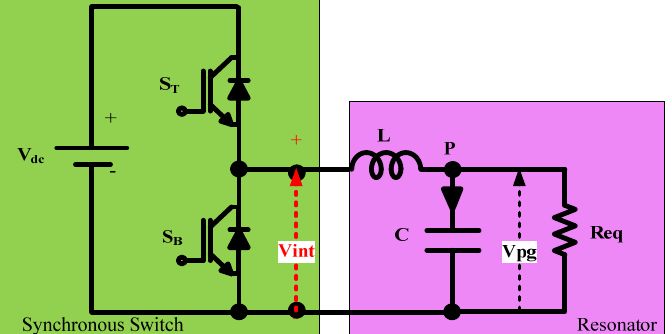
Figure 2. Simplified single-leg equivalence.